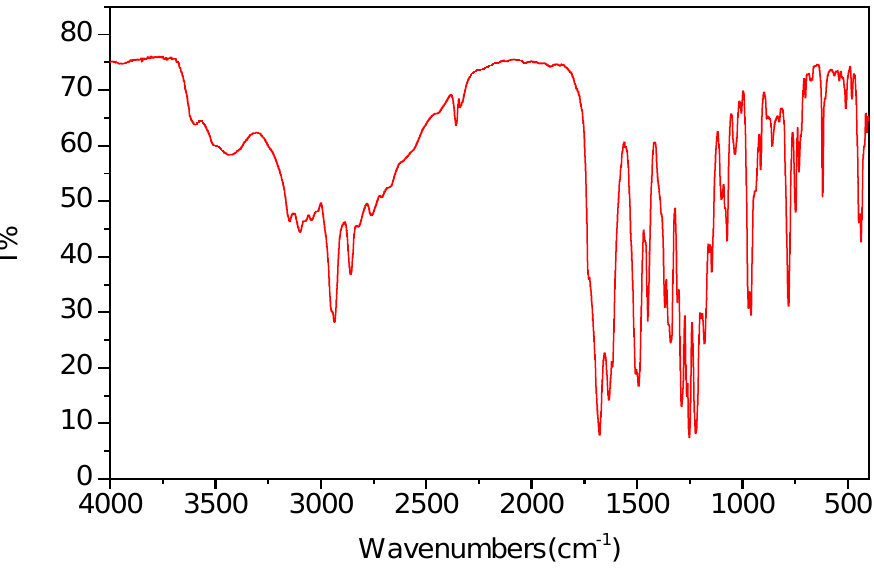
Figure 5. Infrared spectrum of the title compound.